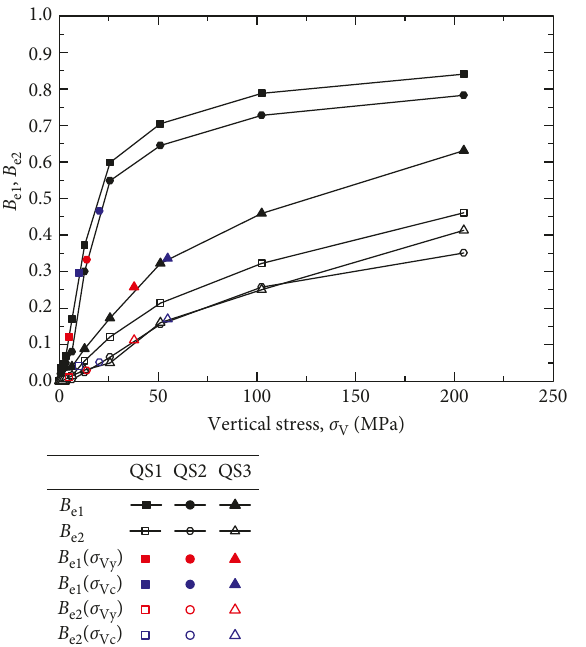
Figure 10: Relationship between σ